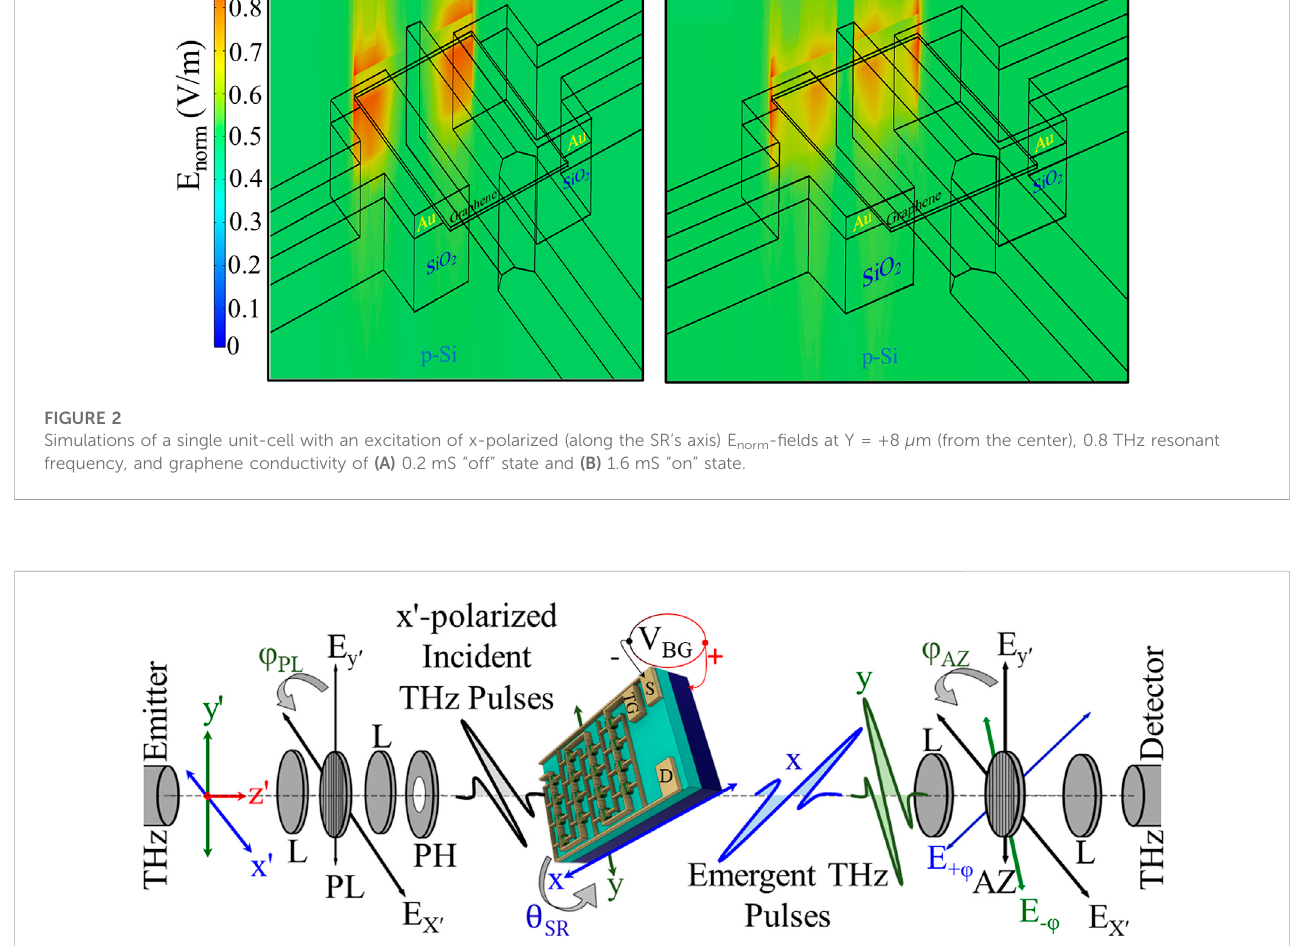
for frequencies above 1 THz clearly appears in the spectral amplitudes of E ref. , E x , and E y as shown in Figure 4B. Upon fi ltering temporal pulses, the acquired E- fi elds are normalized by referencing their spectral amplitudes to E ref. ’ s amplitude, as shown in Figure 5A. At the same time, the extracted spectral phases are normalized by subtracting the spectral phase of E ref. , as plotted in Figure 5B. Separate E ref. waveforms were acquired each time the device was rotated while orienting both the PL and AZ to vertical grids (full transmission) position. A component of the incident E- fi eld is parallel to the SR ’ s plane of incident (E x ), while the other is perpendicular to the SR ’ s plane of incident (E y ). 5 o to 75 o . The MD was extracted for each θ SR angels from the